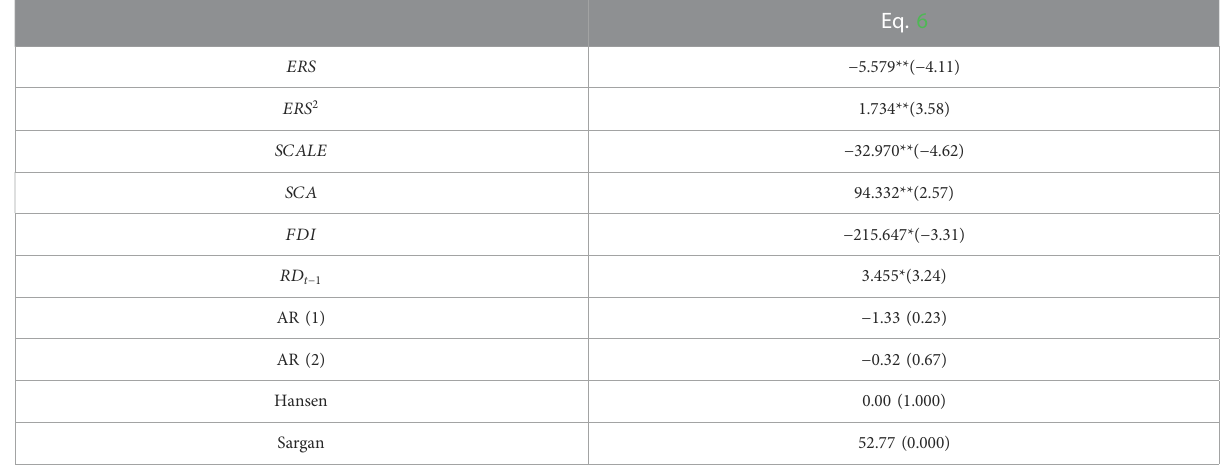
TABLE 3 Regression results of environmental regulation and R&D investment in China ’ s equipment manufacturing